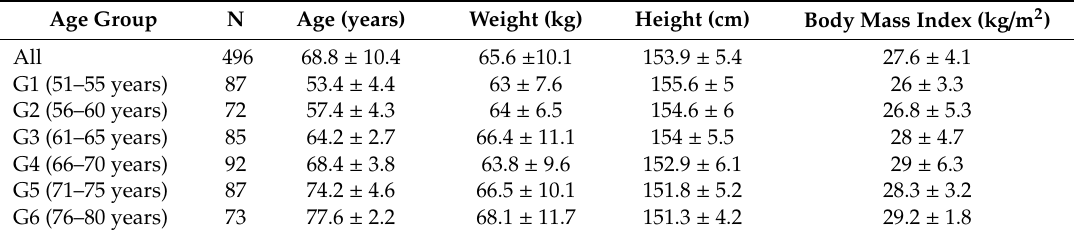
Table 1. Descriptive statistics of anthropometric variables.